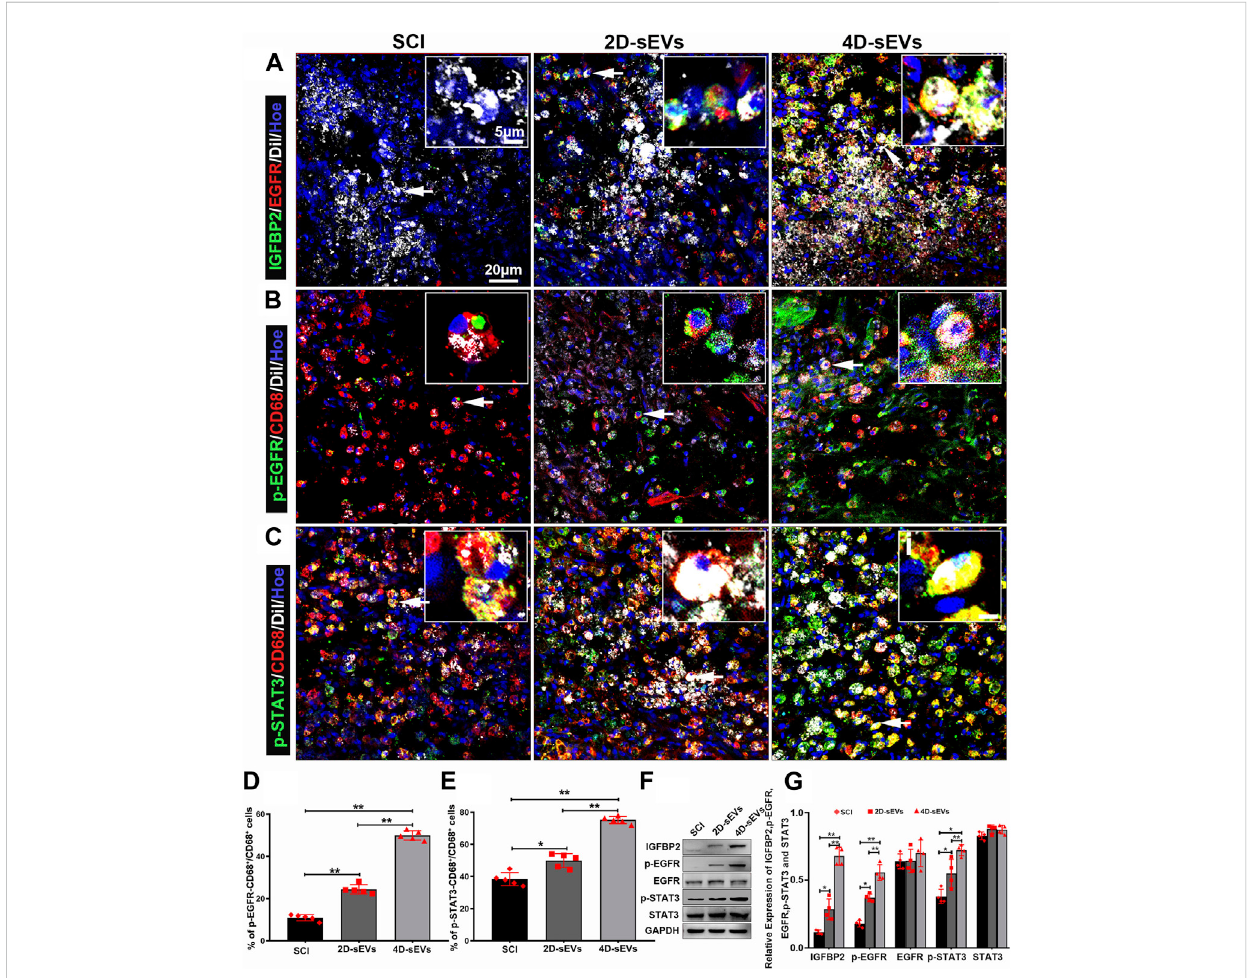
FIGURE 8 SEVs-transported IGFBP2/EGFR protein activates the STAT3 pathway in the injury/graft site of the spinal cord. (A) Fluorescently stained images showingco-labeledIGFBP2(green)andEGFR(red)incellstakingupsEVs(white)intheinjury/graftsiteofthespinalcordinthreegroups. (B) Fluorescently stained images showing p-EGFR + /CD68 + cells to CD68 cells in the injury/graft site of the spinal cord. (C) Fluorescently stained images showing p-STAT3 + /CD68 + cells to CD68 cells in the injury/graft site of the spinal cord. (D) , (E) Bar charts showing the fl uorescence intensity of p-EGFR and p-STAT3. (F) Western blot analysis of protein expression (IGFBP2, p-EGFR, EGFR, p-STAT3, STAT3). (G) : Quantitative analysis of Western blot. Statistic difference: * p < 0.05; ** p <